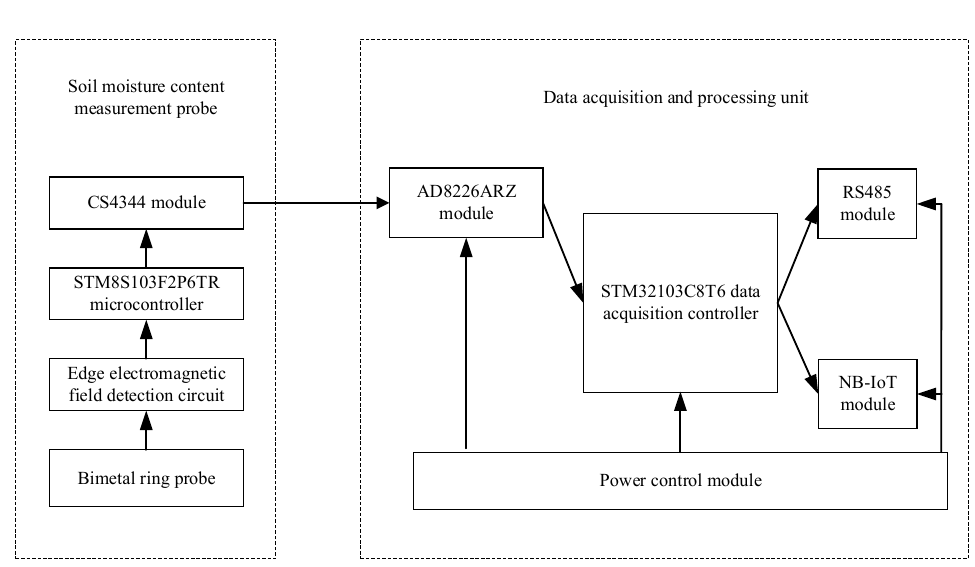
Figure 3. Hardware circuit system block diagram.